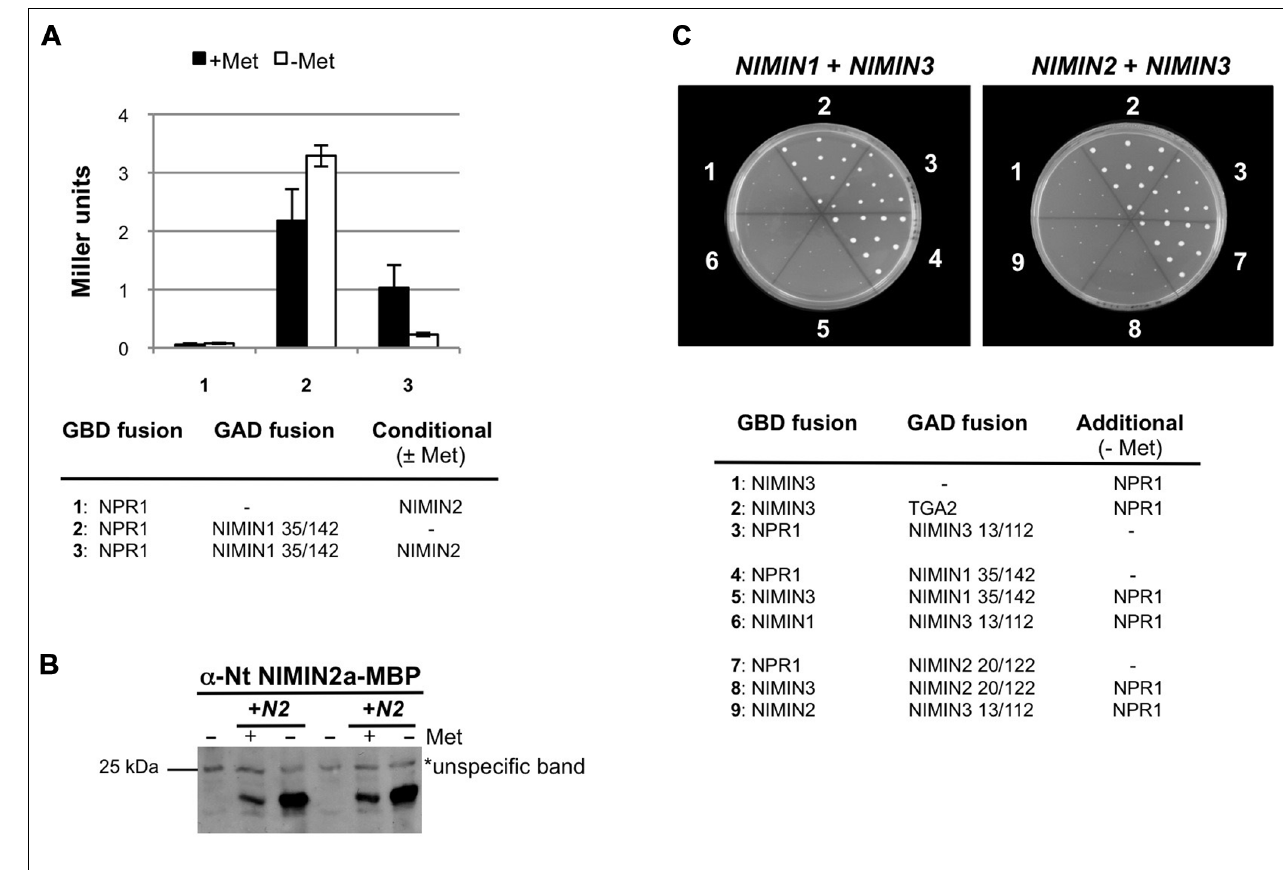
FIGURE 5 | Arabidopsis NIMIN1, NIMIN2, and NIMIN3 do not bind simultaneously toAt NPR1 in yeast. (A) Yeast two-hybrid interaction of At NPR1-Gal4 DNA binding domain (GBD) and NIMIN1-Gal4 activation domain (GAD) fusion proteins in absence and presence of NIMIN2. NIMIN2 was expressed from the Met25 promoter which is repressed in presence and de-repressed in absence of methionine. (B) Immunodetection of NIMIN2 in yeast.Yeast cells analyzed for lacZ reporter gene expression in